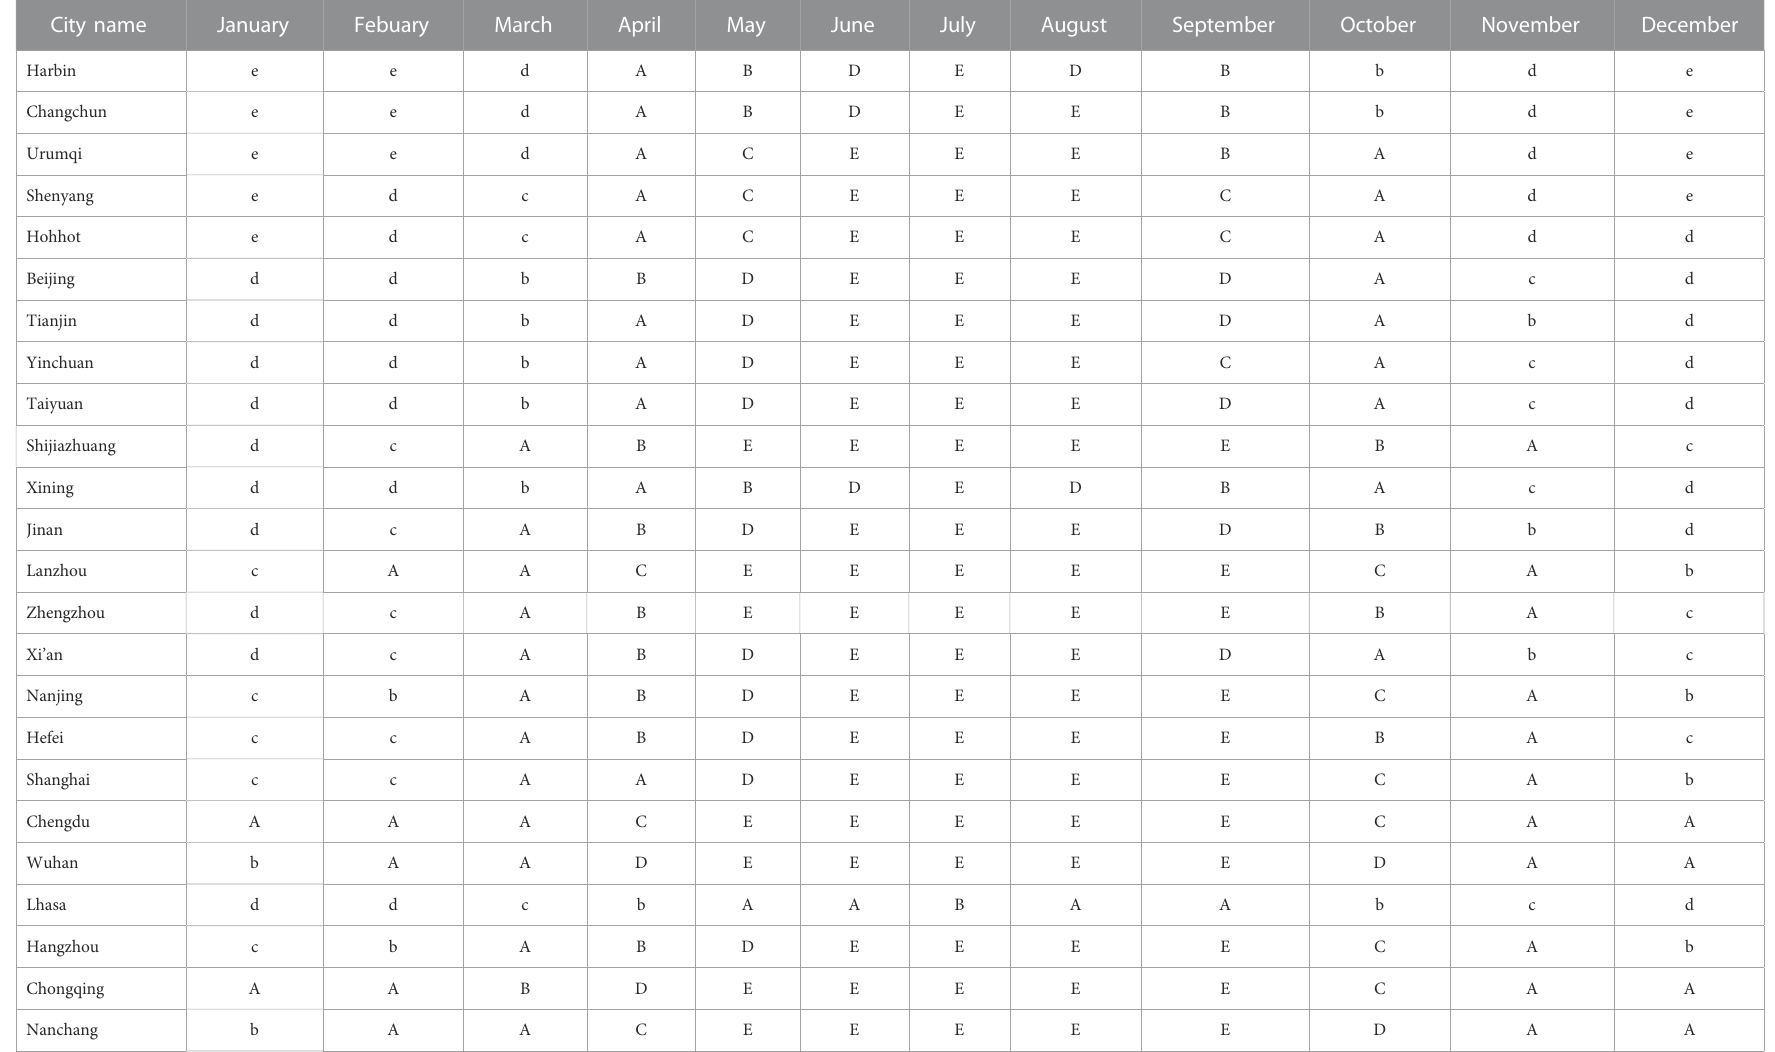
TABLE 5 Characteristics of the climate comfort in 31 mainland Chinese cities during 1980 – 2019 using ICL-new